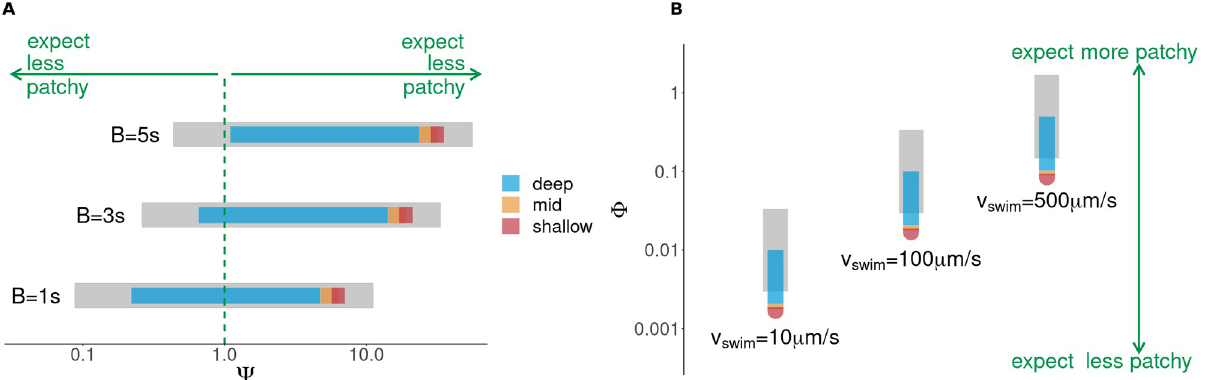
Fig 2. Dimensionless stability ( C ) and swimming ( F ) number values for microbes at different depths within our IBM. Expected patchiness is greater when C � 1 and for large F . (a) The stability number C of simulated microbes varied through the Deep (light blue), Mid (yellow) and Shallow (red) depth regions of the flow. To contextualise our simulations with respect to real world flows, grey boxes illustrate the range of the stability number C at expected values of � and ν within a convective oceanic mixed layer (see S2 Text). The stability number C of our microbes is broadly similar to that expected in such real world conditions. (b) The swimming number F of simulated microbes also varied through the Deep (light blue), Mid (yellow) and Shallow (red) depth regions of the flow. Here again, grey boxes illustrate the range of the swimming number F at expected values of � and ν within a convective oceanic mixed layer convective turbulence (see again S2 Text). The swimming number of microbes in our IBM overlaps with realistic values, but was generally lower (see Discussion).